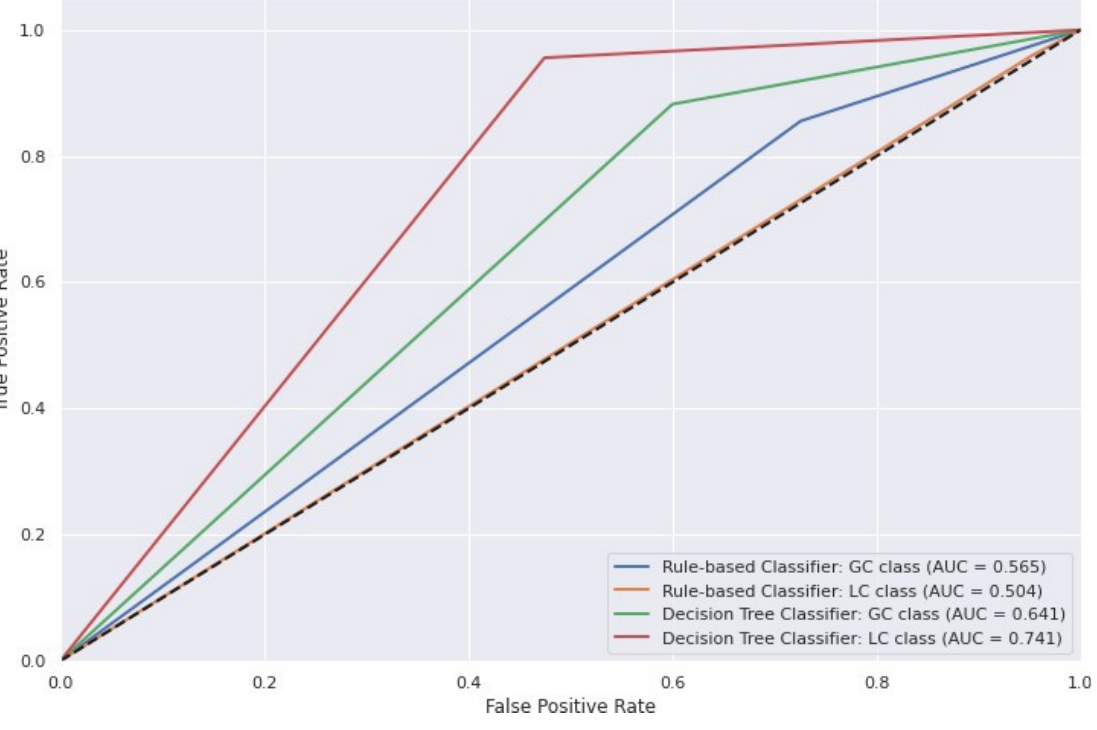
Figure 3. Receiver operating characteristic (ROC) curve analysis.